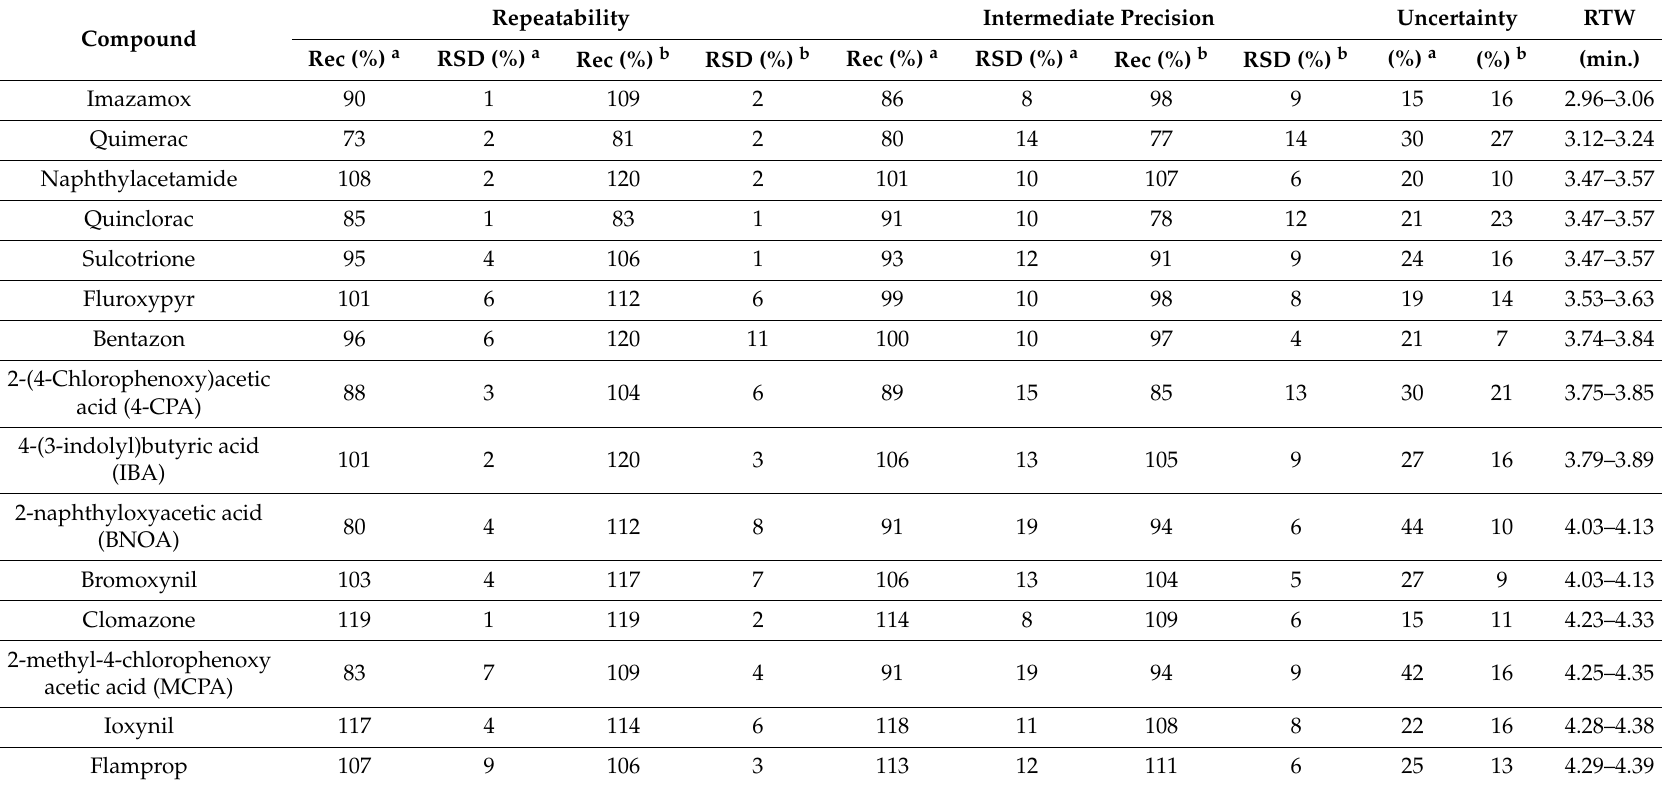
Table 3. Retention time windows and validation parameters for the target compounds in